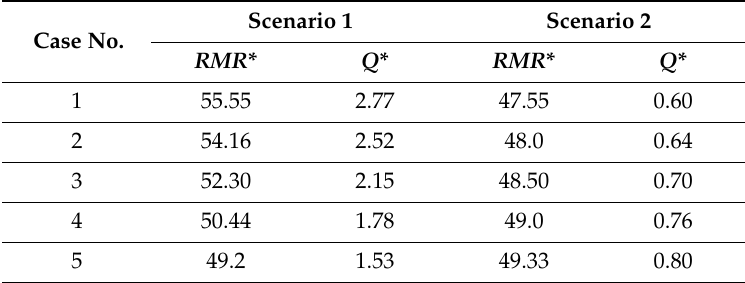
Table 7. Back-calculated rock-mass quality values for two di ff erent scenarios of Example 1 based on the weightage cases of Table 6. Case